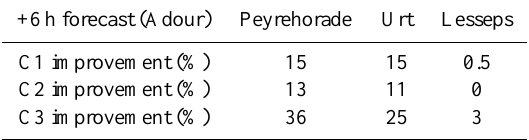
Table 2. C1, C2, C3 improvement between Free run and Assim run over the six hours after the reference time. Average of seven flood events in the Adour catchment, at Peyrehorade, Urt and Lesseps.